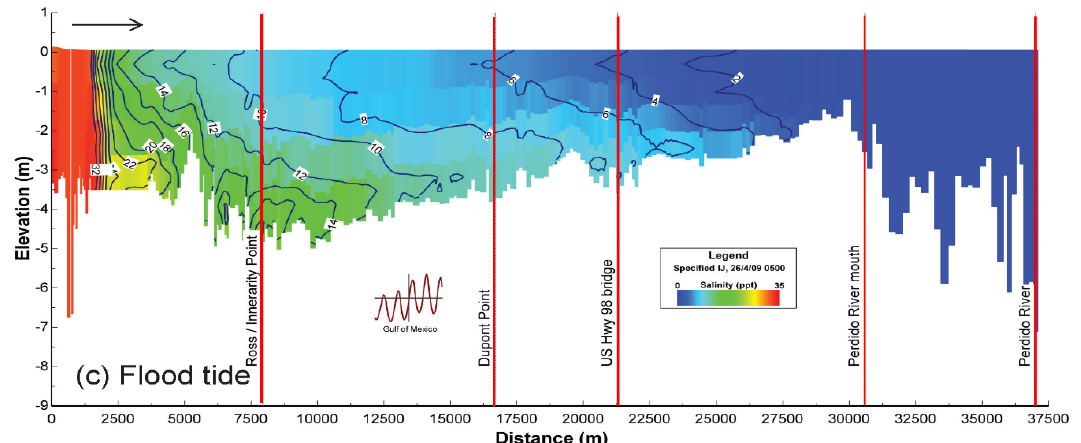
Figure 3. Simulated salinity profile contour plots through the centerline (Figure 1) from Perdido Pass to Perdido River during low flows from upstream under ( a ) ebb tide (15:00 25 April 2009) ( b ) the lowest water surface elevation (21:00 25 April 2009); and ( c ) flood tide (05:00 26 April 2009) at the Gulf of Mexico. Simulated salinity contour lines of 0–34 psu are shown in addition to colored contour